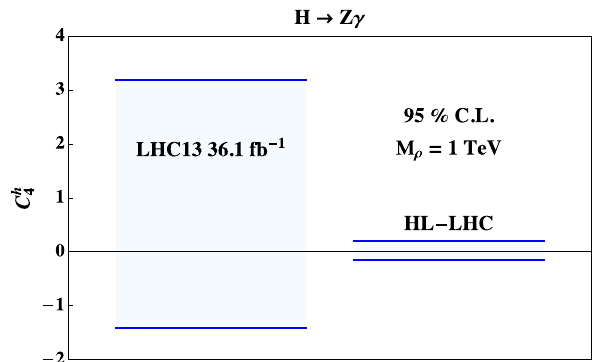
Fig. 7 Theboundon C h fromH → Z γ on-shellmeasurementatthe13 4 TeV LHC with luminosity L = 36 . 1 fb − 1 [51] and from the prospective HL-LHC